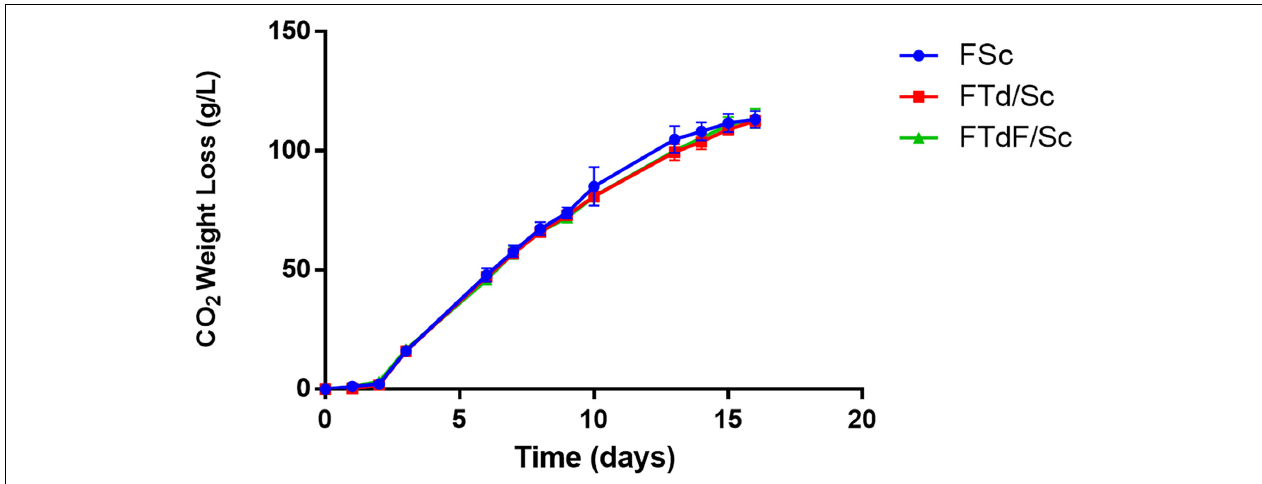
FIGURE 5 | Fermentation kinetics of Chardonnay wines produced by pure S. cerevisiae fermentation (FSc) and co-inoculated fermentations FTd/Sc and FTdF/Sc.